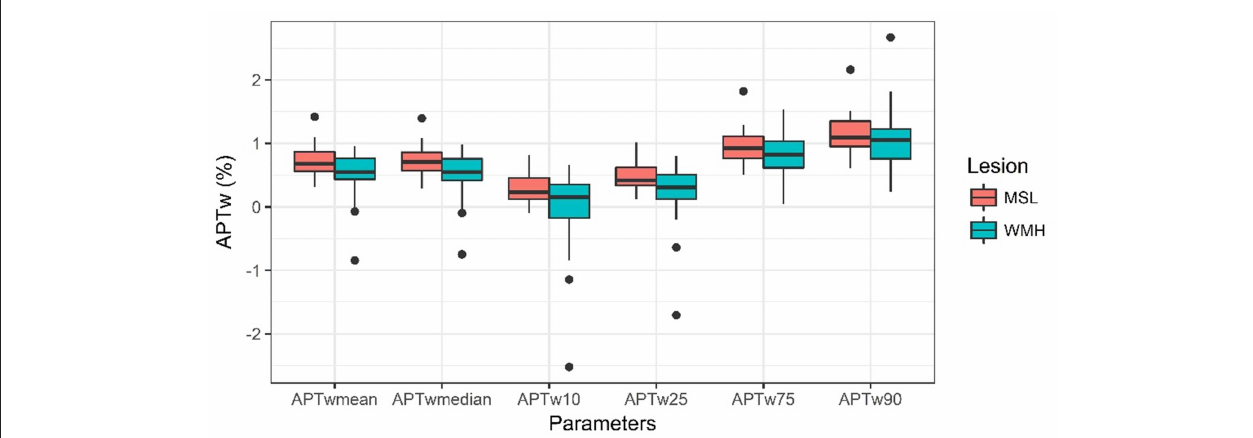
FIGURE 5 | Comparison of histogram parameters (mean, median, 10th percentile, 25th percentile, 75th percentile and 90th percentile) of APTw data from MS lesions (MSL) ( n = 27) and white matter hyperintensities of presumed vascular origin (WMH) ( n = 35) that were averaged for each patient. The line in the box shows the median, the lower and upper hinges correspond to the first and third quartiles, the upper/lower whisker extends from the hinge to the largest/smallest value no further than 1.5 * IQR from the hinge.